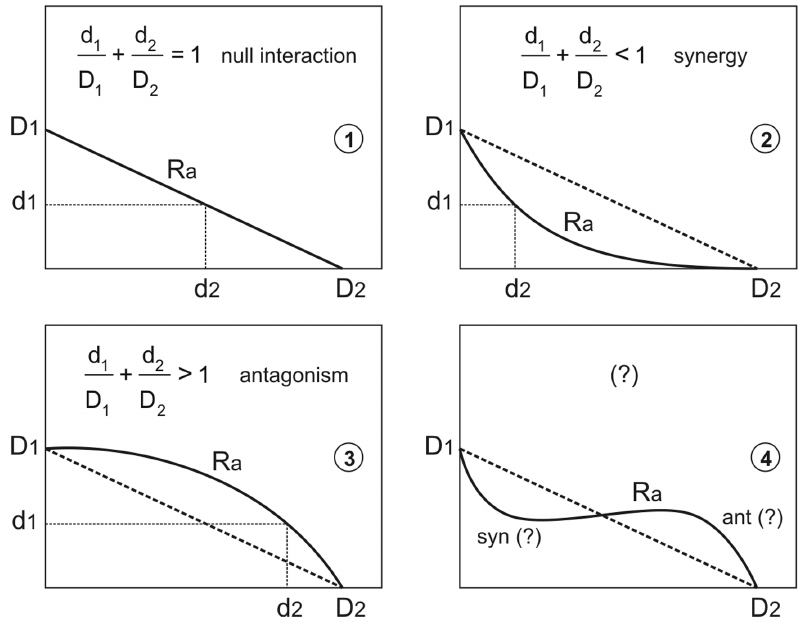
Figure 1. Isobole of a response R a . In 1, 2 and 3 the geometric logic underlying the analysis of the CA hypothesis through the equation (4) is shown. Type 4 isoboles arise in many real responses corresponding to the IA hypothesis with null interaction, and illustrate the limitations of the relation between factual and formal aspects of isobole analysis beyond a particular case of the CA mode of action (see results, section 5).